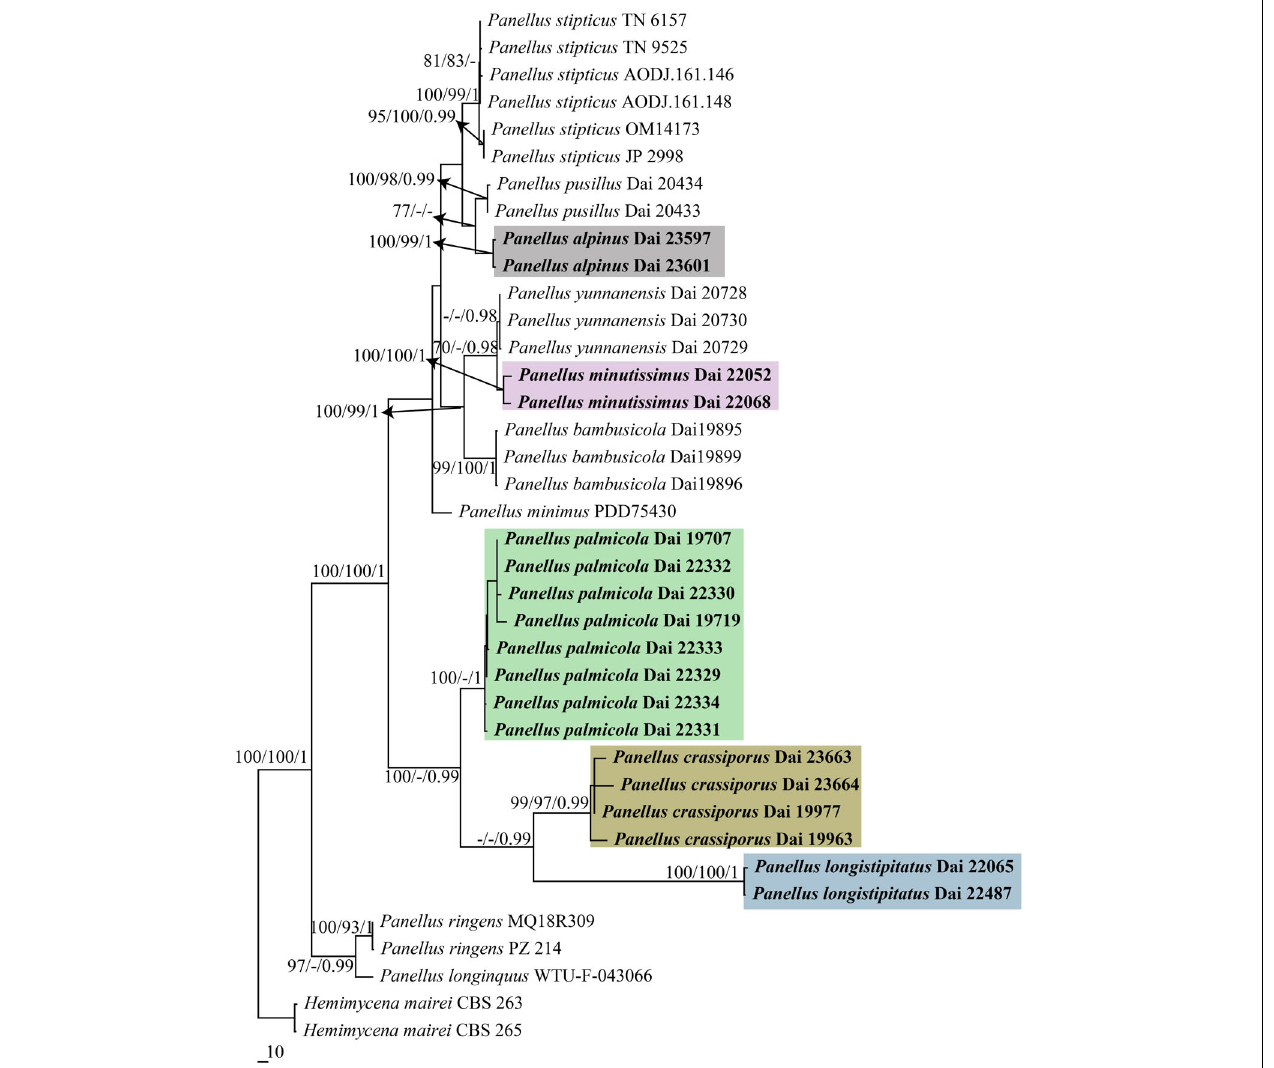
FIGURE 2 | Maximum parsimony (MP) tree illustrating the phylogeny of Panellus based on combined 5-gene (nrITS + nrLSU + mtSSU + nrSSU + tef 1) dataset. Branches are labeled with parsimony bootstrap values (MP/ML) higher than 75% and Bayesian posterior probabilities (BPPs) more than 0.95. The five colors represent the five new species in this paper,